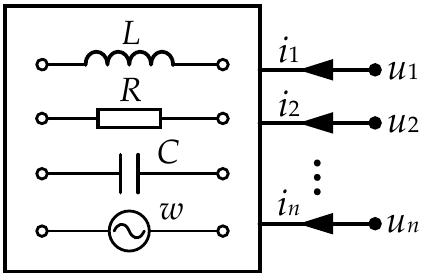
Figure 1. Schematic diagram of sub-network.